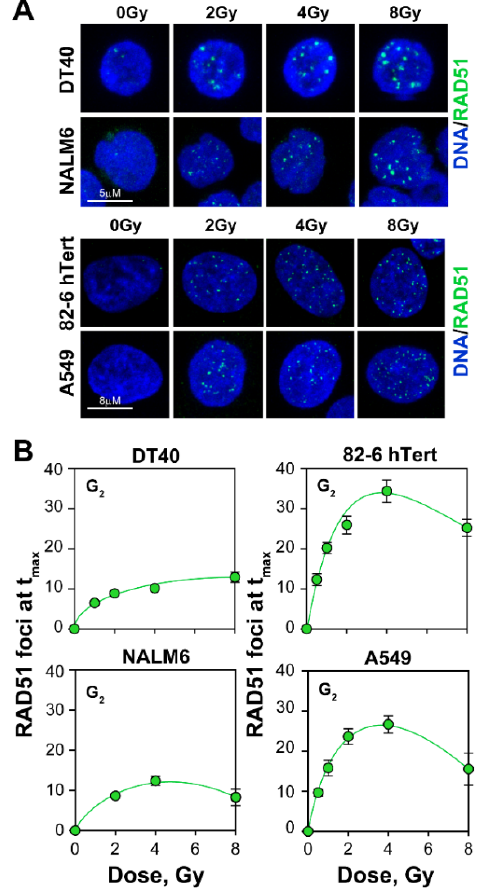
Figure 3. Formation of RAD51 foci, a marker for ongoing HR repair, at DSBs is suppressed at high radiation doses: ( A ) Representative IF images of RAD51 foci in DT40, NALM6, 82-6 hTert and A549 cells; ( B ) QIBC analysis of RAD51 foci in lymphoblastoid and other somatic cell lines. The dose response curves are derived from the repair kinetic experiments (Figure S5) and represent the formation of RAD51 foci at their dose-specific maximum (t max ). Data indicate the mean and standard deviations from 3 independent experiments.